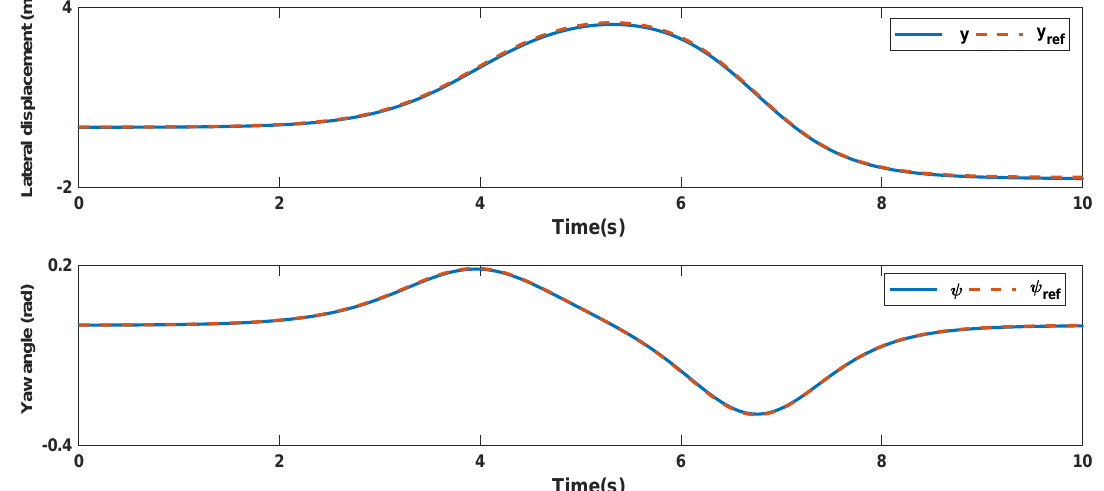
Figure 5. Lateral displacement and Yaw angle.